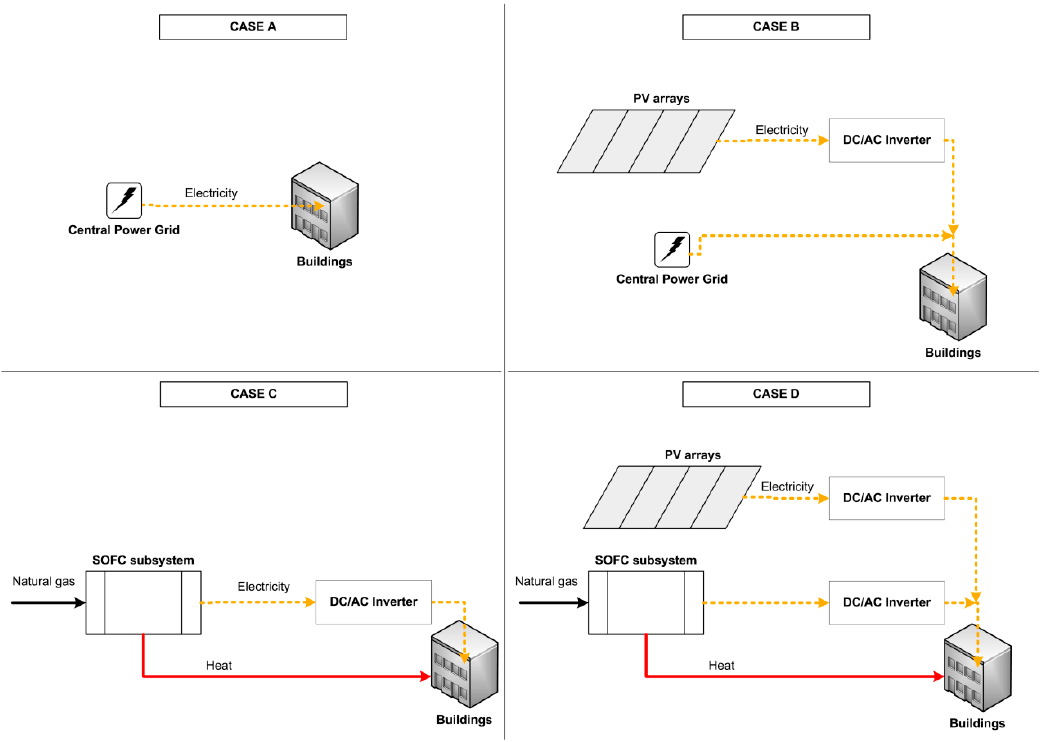
Figure 4. Schematic representation of the four considered cases: ( A ) Power supply from a central power grid (conventional case), ( B ) power supply from a central power grid assisted with an on-site PV system, ( C ) power (and heat) supply from a decentralized SOFC system, and ( D ) power (and heat) supply from the proposed hybrid PV-SOFC system. Energies 2018 , 11 ,